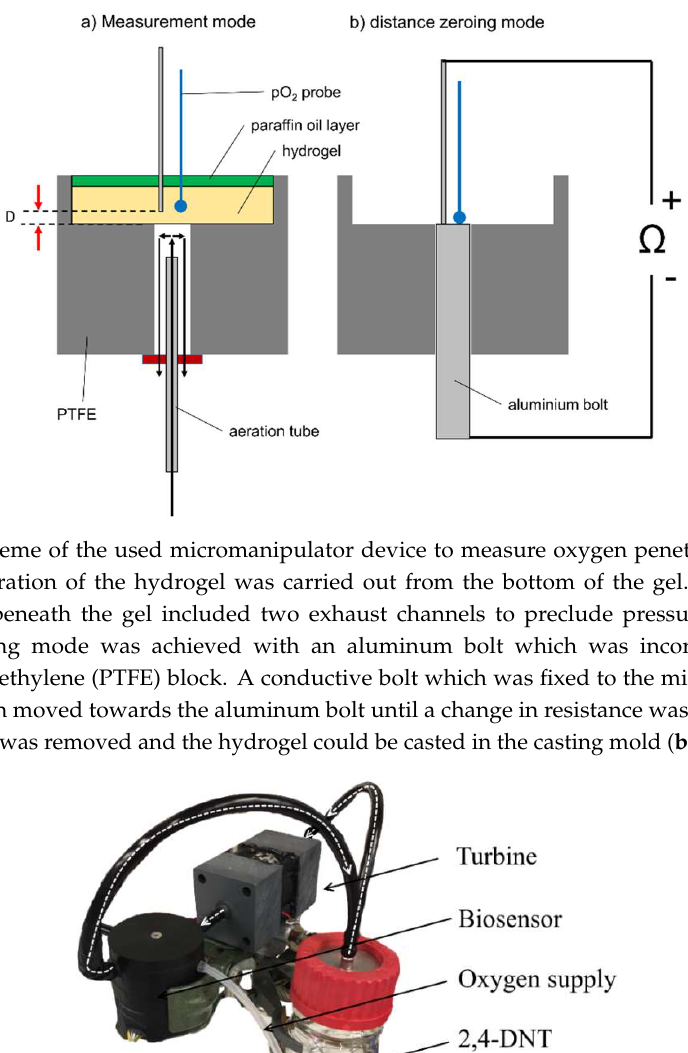
then analyzed using GC-MS.